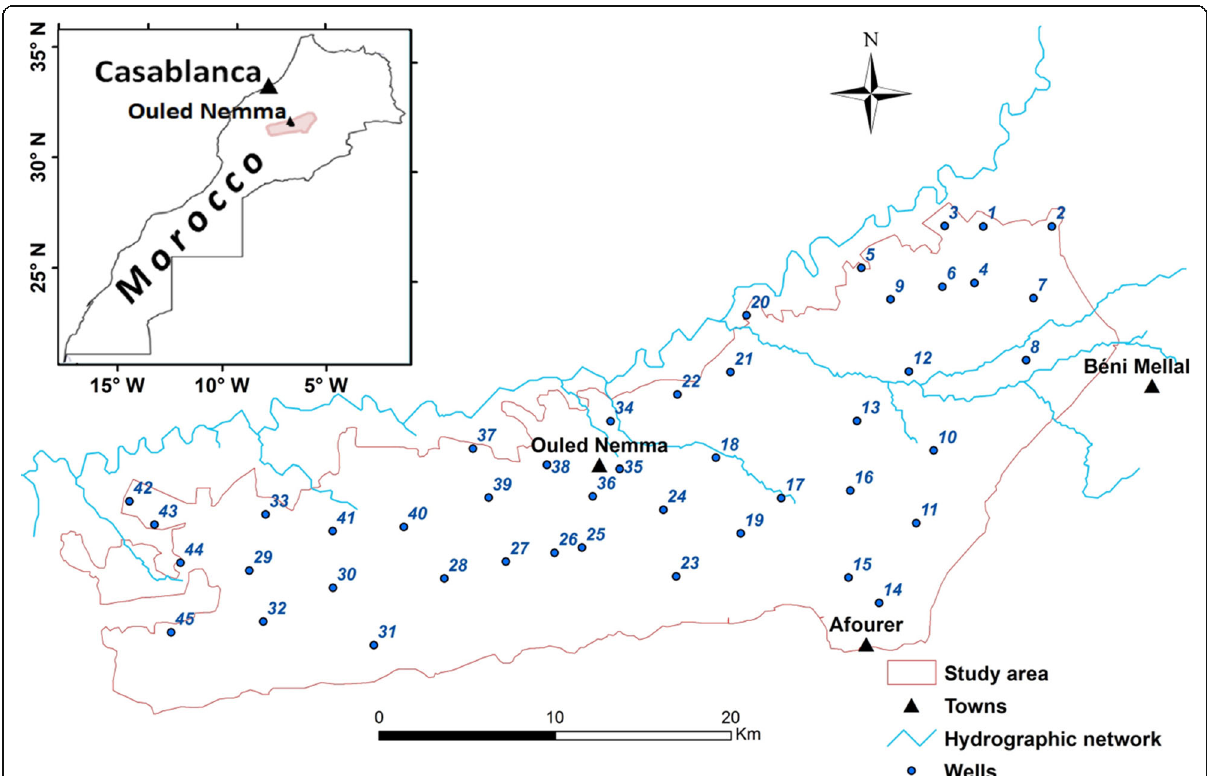
Fig. 1 Location of the study area and groundwater sampling